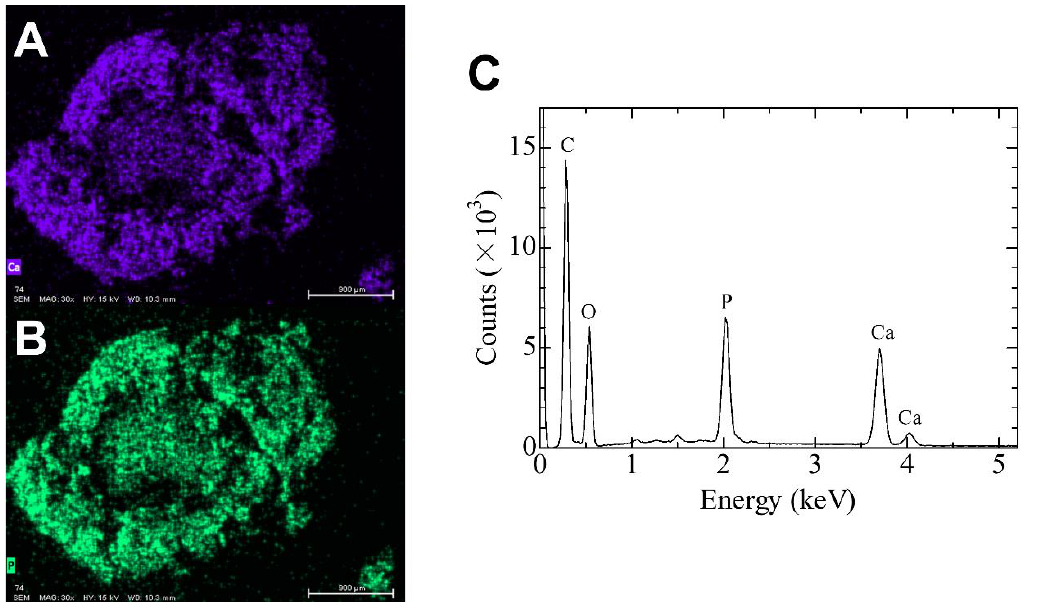
Figure 8. Elemental distribution images of ( A ) Ca and ( B ) P. ( C ) The EDS spectrum for the entire specimen (from Figure 6A) obtained by SEM/EDS.